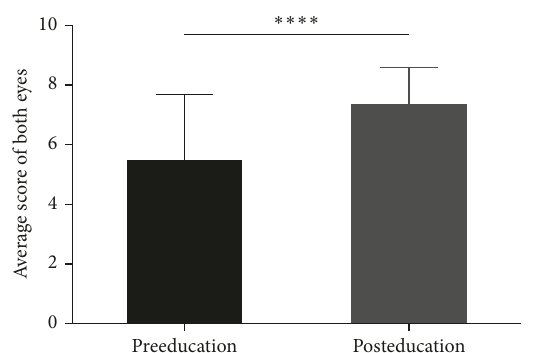
Figure 1: The difference of eye drop technique score between preeducation and posteducation group